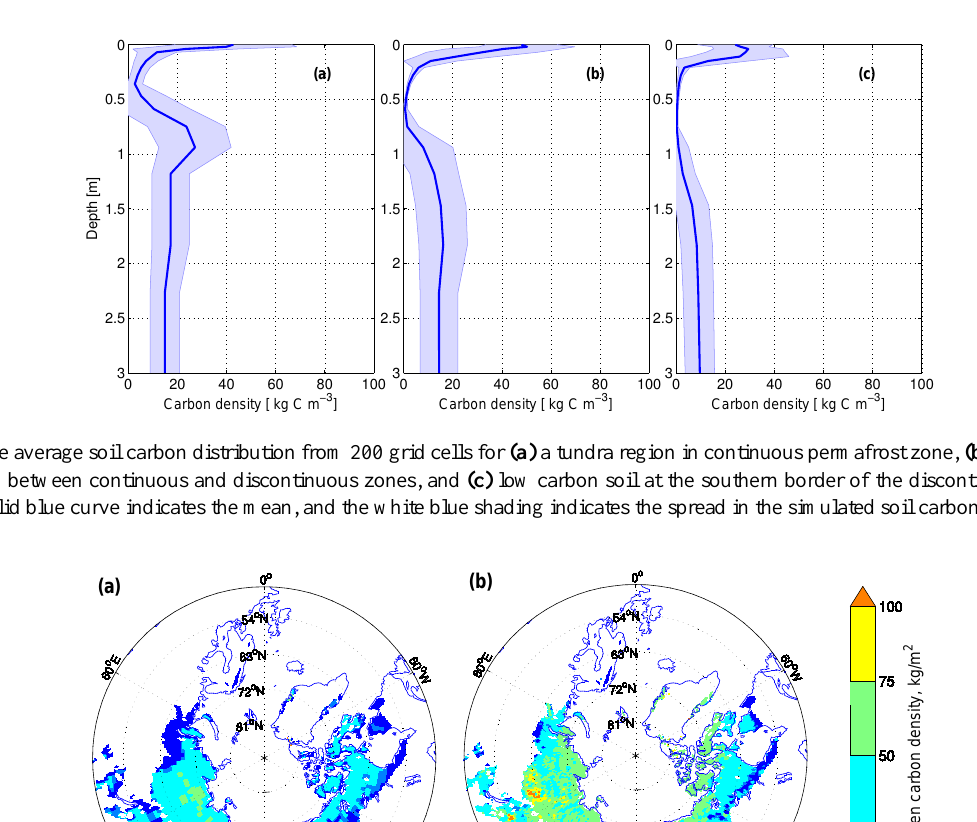
when the soil is thawed essentially synchronizes all pheno- logical events to occur at the same time (Fig.